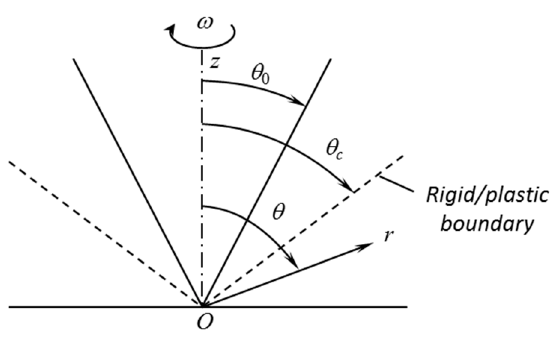
Figure 2. Illustration of the boundary value problem. 75